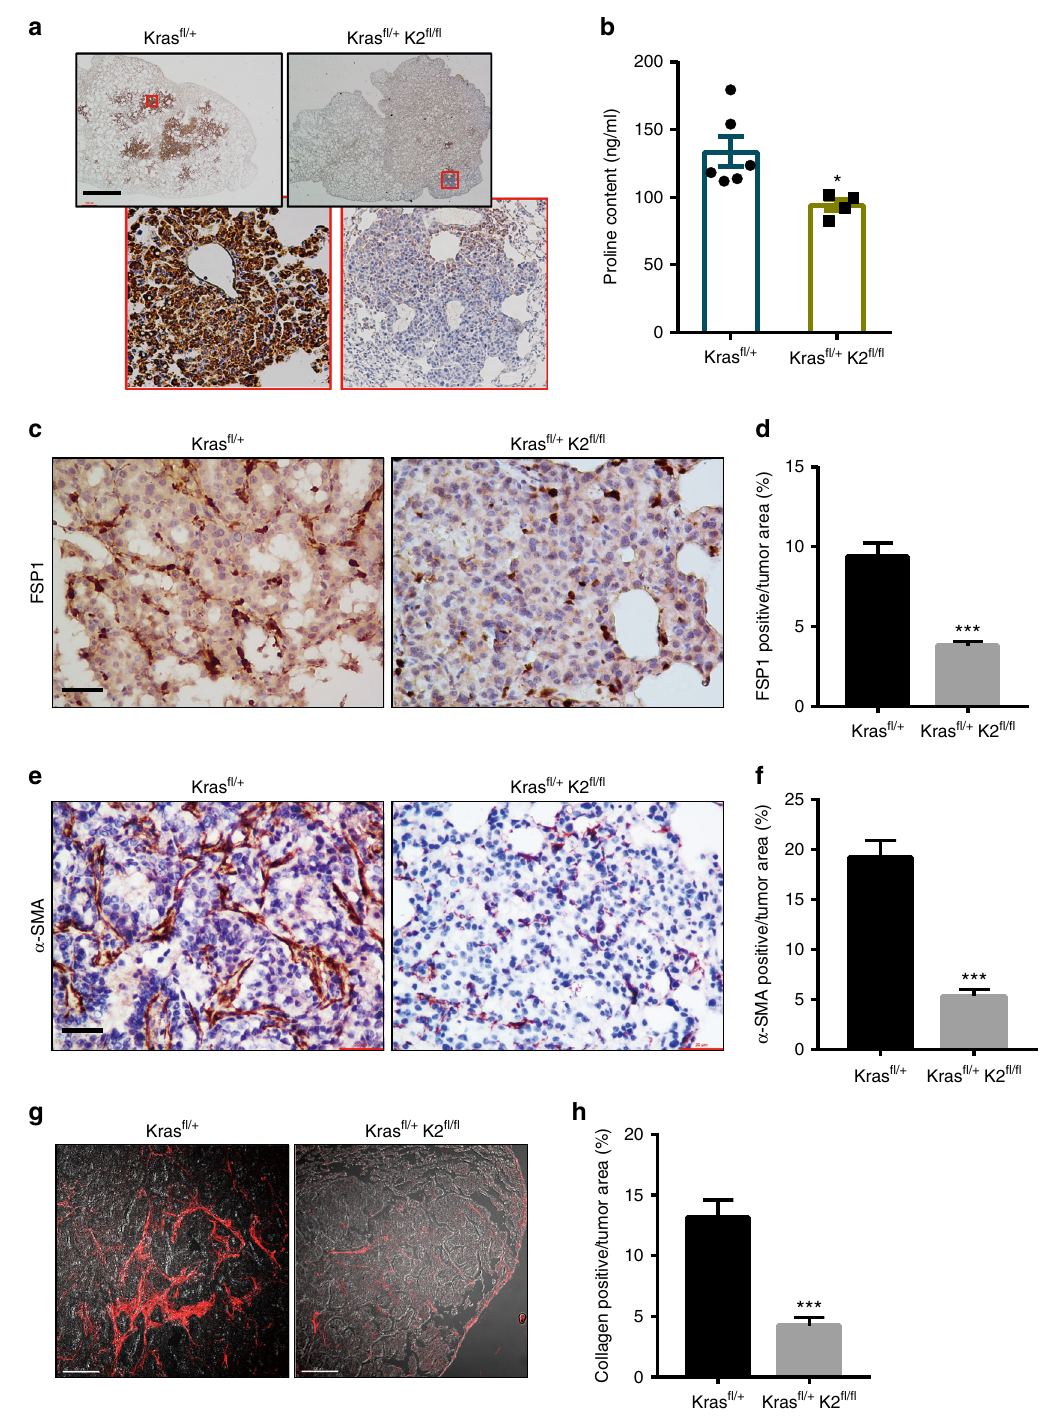
Fig. 10 Ablation of kindlin-2 in lung adenocarcinoma substantially reduces PYCR1 and proline levels, and fi brosis in vivo. a – h The lung of the mice (as indicated in the fi gure) was administrated with Ad-Cre and analyzed 16 weeks later. Sections of the lung tissues from the mice (as speci fi ed in the fi gure) were analyzed by immunostaining with anti-PYCR1 antibody ( a ). Scale bar = 300 μ m. The proline levels in the lung tissues were analyzed as described in the Methods ( b , Kras fl / + group n = 6; Kras fl / + ; K2 fl / fl group n = 4). Sections of the lung tissues from the mice (as speci fi ed in the fi gure) were analyzed by immunostaining with an antibody for fi broblast-speci fi c protein 1 (FSP1), a marker of fi broblasts ( c ). Scale bar = 20 μ m. ( d ) The percentages of FSP1- positive areas among total tumor areas were quanti fi ed (at least 25 fi elds from 4 mice were counted). Sections of the lung tissues from the mice (as speci fi ed in the fi gure) were analyzed by immunostaining with an antibody for myo fi broblast marker α -SMA ( e ). Scale bar = 20 μ m. f The percentages of α -SMA-positive areas among total tumor areas were quanti fi ed (at least 35 fi elds from 4 mice were counted). Sections of the lung tissues from the mice (as indicated in the fi gure) in which collagen fi bers were analyzed by second harmonic generation (SHG) with multiphoton microscopy are shown ( g ). Scale bar in g , 100 μ m. The percentages of collagen matrix-positive areas among total tumor areas were quanti fi ed ( h , at least 30 fi elds from 4 mice were counted). Data in b , d , f , h represent mean ± SEM. Statistical signi fi cance was calculated using two-tailed unpaired Student ’ s t -test, * P < 0.05; *** P <